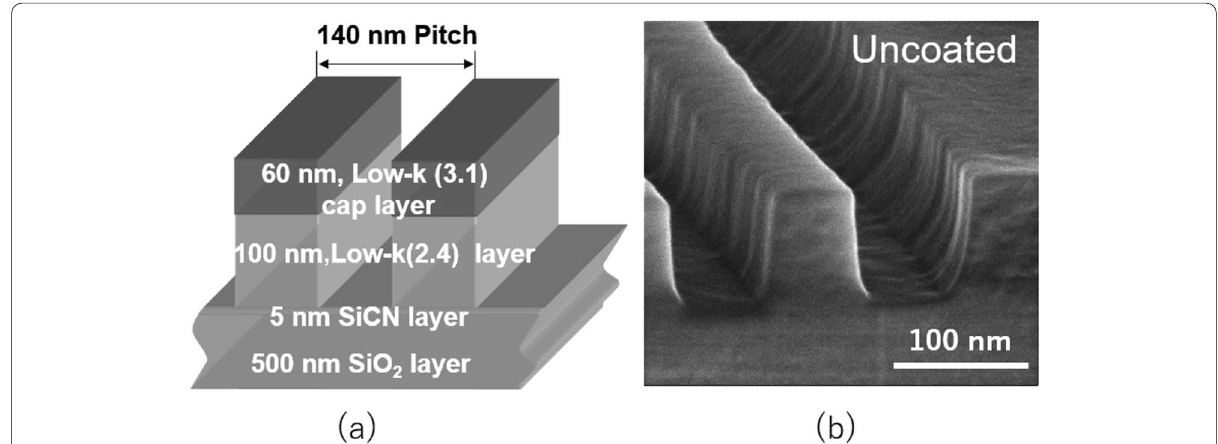
Fig. 2 a A diagram of a low-k interlayer insulating film pattern before embedding copper interconnects and b a HIM image of the actual structure. Note that a conductive thin film to prevent charge-up did not have to be applied to this specimen. Figure modified from